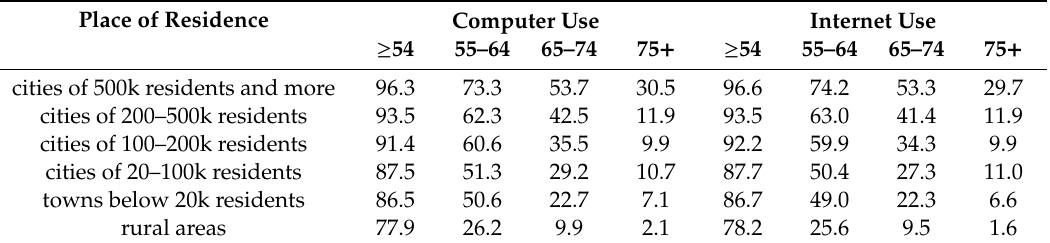
Table 3. The use of computers and the Internet in Poland by age groups in cities and in rural areas (in